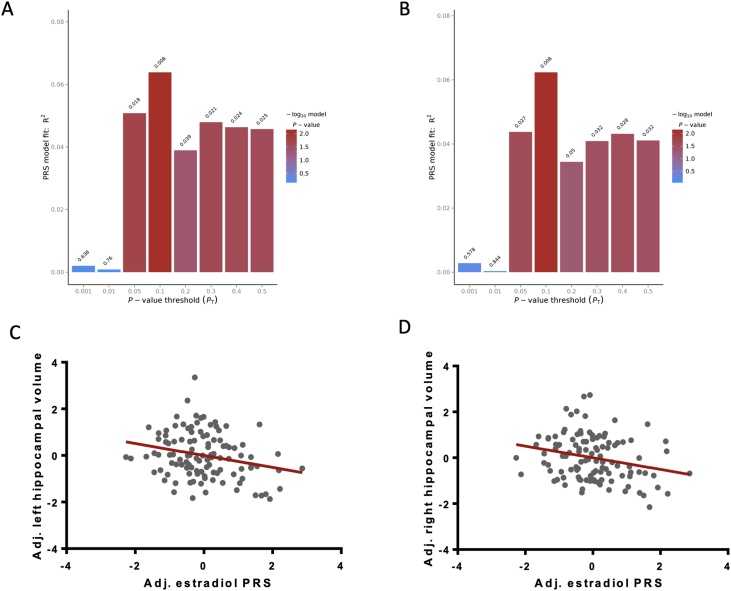
A&B) Output from PRSice displaying the results of regressing the estradiol PRS against the (A) left and (B) right hippocampal volume at the range of p-value thresholds tested (x-axis). A combination of SNP information under p=0.1 significantly best predicted both left and right hippocampal volumes. Variance explained (R2) is indicated on the y-axis and uncorrected p-values are indicated above each bar. C&D) Scatterplots demonstrating significant negative correlations between the best-fit PRS for estradiol levels (z-scores; adjusted for 7 population covariates derived from multidimensional scaling to control for population stratification) and whole hippocampal volumes (z-scores; adjusted for intracranial volume, age, sex, case-control status) for the (C) left and (D) right hemispheres. (For interpretation of the references to colour in this figure legend, the reader is referred to the web version of this article).